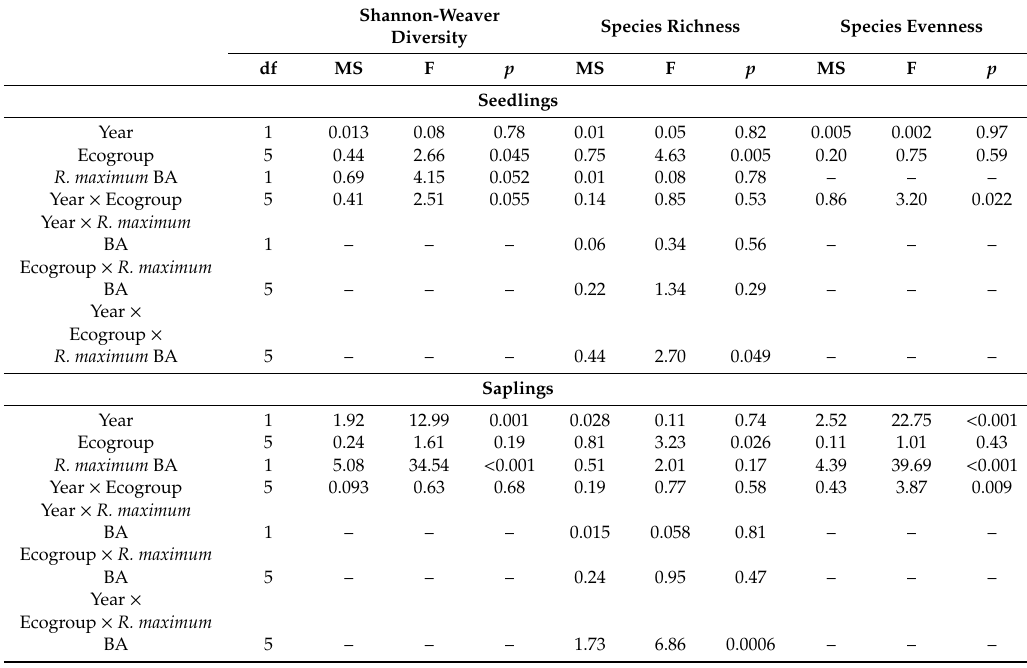
Table 5. General linear mixed model ANOVA results for diversity metrics across both woody strata. Shannon-Weaver Species Richness Species Diversity